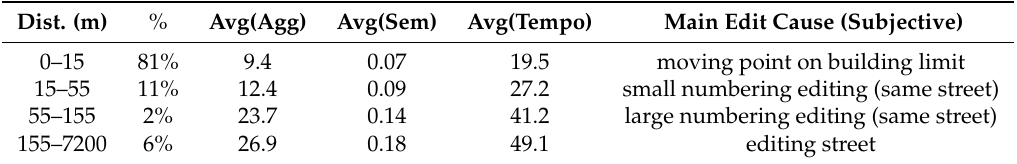
Figure 13. A textual address data set was geocoded, then manually corrected by a historian. We plotted the segment between the geocoded addresses and the corrected addresses, and analysed the results based on the magnitude of the spatial error. Table 2. Evaluating the error of geocoded results, via the geographic distance (dist.) of the edit (in metres), the percentage of the total 8823 addresses, the average aggregated distance score (Avg(Agg)), the average string distance (Avg(Sem)), or should the table column heading be changed? , the average temporal distance (Avg(Tempo)), and the subjective most common reason for edits that we encountered while browsing the